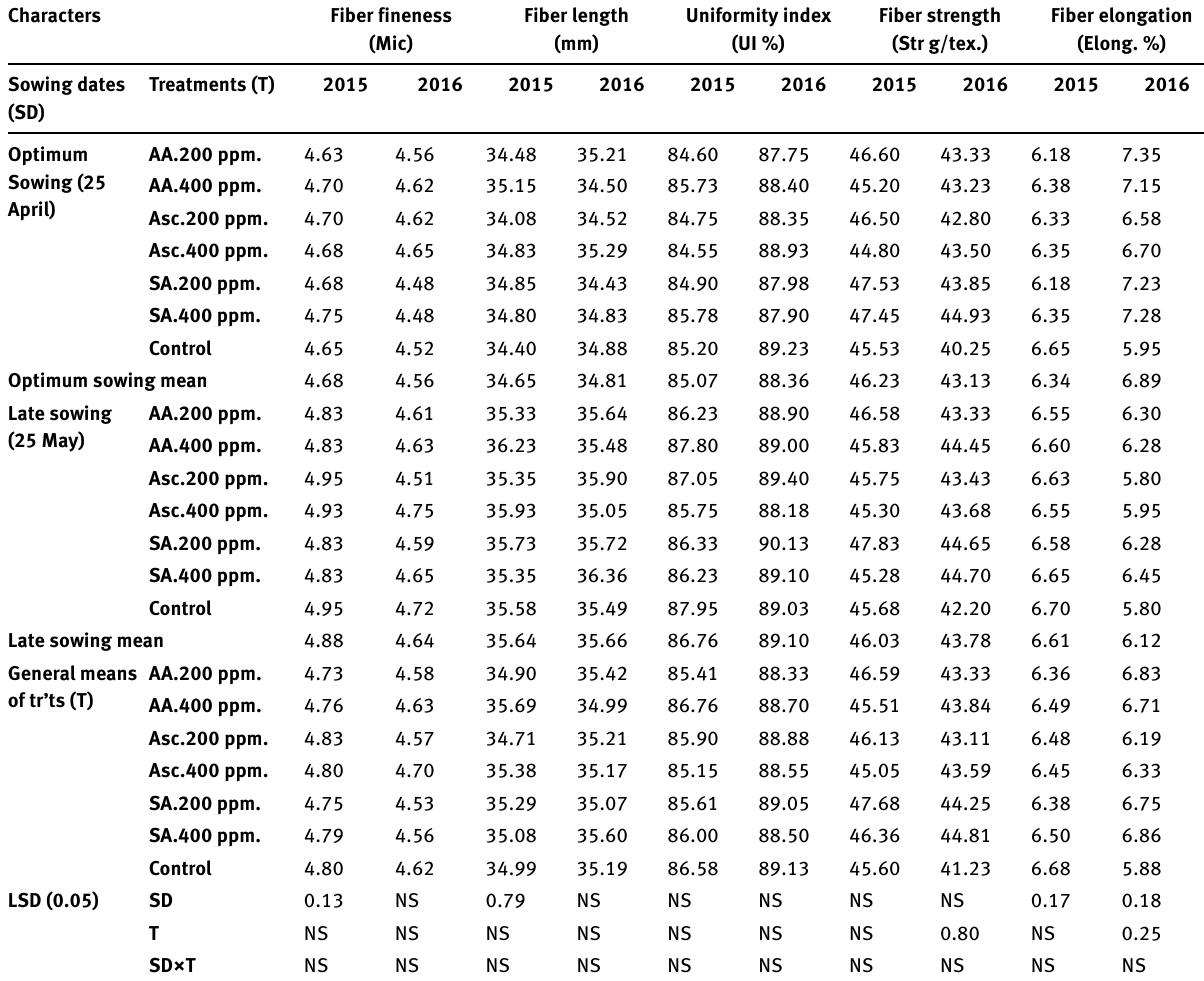
Table 8: Fiber fineness (Mic), fiber length mm (UHM), uniformity index (UI%), fiber strength (Str g/tex.) and fiber elongation (Elong. %) as affected by foliar applications of ascorbic, ascobine and salicylic acids under optimum and late sown heat stress condition in both